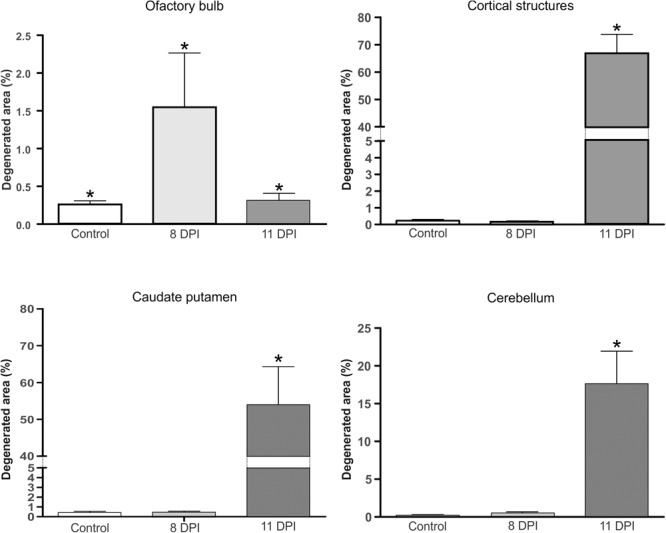
Percentage of the neurodegenerated area in brains of 8 (light gray bars) or 11 DPI (dark gray bars) mice, revealed by A-Cu-Ag staining, in olfactory bulb, cortical structures, caudate putamen, and cerebellum. Results are representative of three independent experiments, and uninfected mice were included as controls (white bars). (∗) Indicates a statistically significant association between the percentage of degenerated areas and the different mice models (control, 8 DPI, and 11 DPI) (P < 0.005).